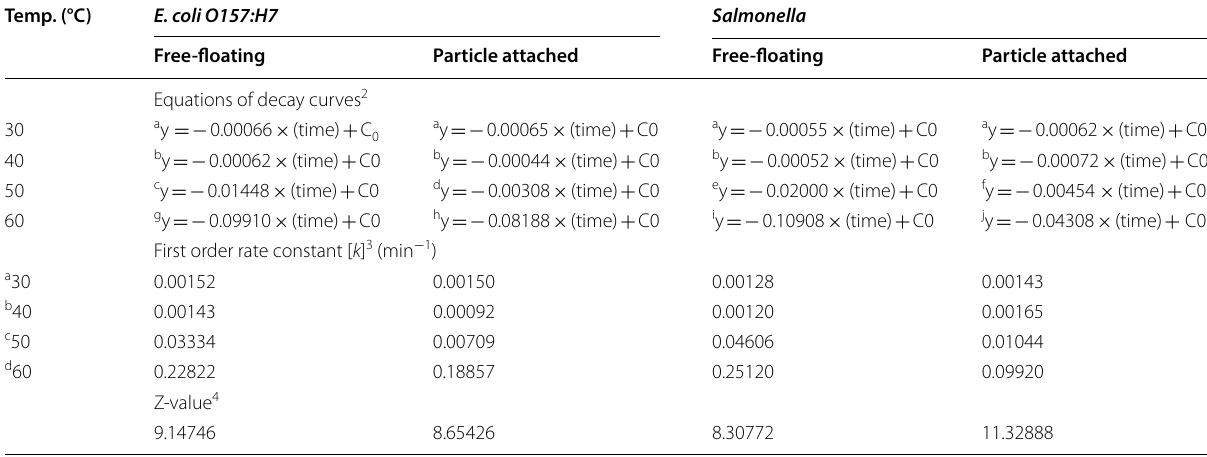
Different letters in subscript of regression equations shows the line is significantly different at p < 0.05 Similar letters in subscript of z - values show the values are not significantly different at p < 0.05 Different letters in subscript of k - values show that these values were significantly different among temperature at p < 0.05 1 C 0 = initial pathogen concentration (CFU/mL) 2 R 2 values for decay curve varied between 0.75 and 0.99 3 Rate constant (k) was estimated from D-values (k 2.303/D) = 4 The Z-values were estimated based on slope (i.e., z-value 1/(slope between temperature and D-value) = −